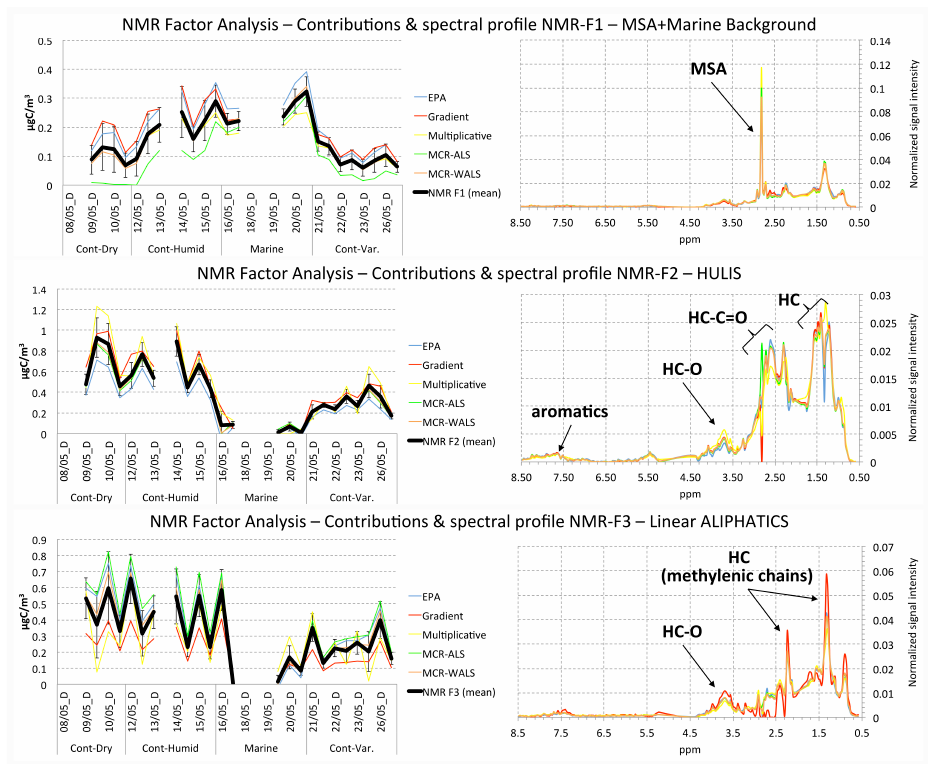
Fig. 1. Average PM 1 -filters’ chemical composition and back-trajectory analysis for the four periods of the campaign. Organics are reported · 1.6. as total organic matter (OM) calculated by the relationship OM=OC PM 1 filters Table 1. Periods of the campaign with average meteorological conditions. Days Period ID RH% Wind (ms − 1 ) Comments Period 1 9–12 May Cont-Dry 40.2 Continental, windy, dry Period 2